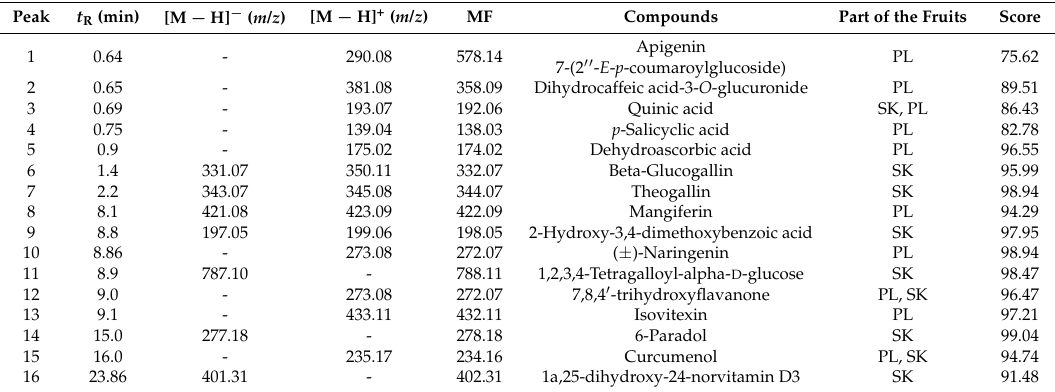
Table 4. Polyphenols identified in the peel and seed kernel extract of M. odorata by LC-ESI-Q-TOF-MS. Peak